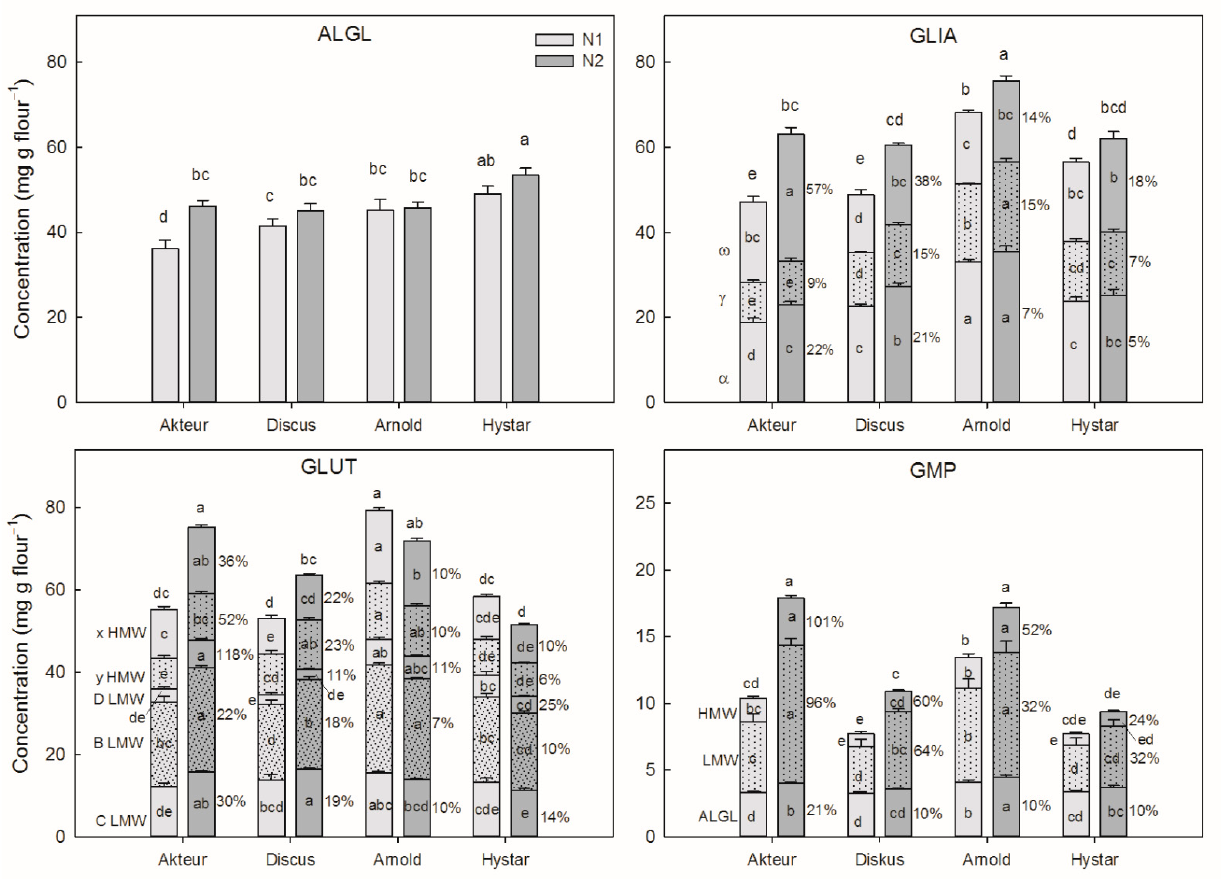
Figure 2. Effect of N2 and cultivar on ALGL concentration, and on concentration of the fractions of GLIA, GLUT and GMP. On the left side of the diagrams, it is indicated which protein fractions belong to which bar section. The numbers indicate the effect of N2 (in percent) on the different fractions. The cultivar names are displayed on the x-axis. Different letters indicate significant differences ( p < 0.05) (within the bar sections between the individual fraction means and on the bars between total concentrations). Error bars (S.E.M) for the fraction means are displayed.